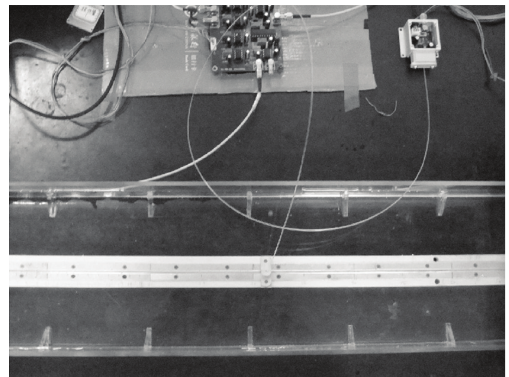
Figure 5: Experimental setup of attenuation coe ffi cient measure- ment for straight